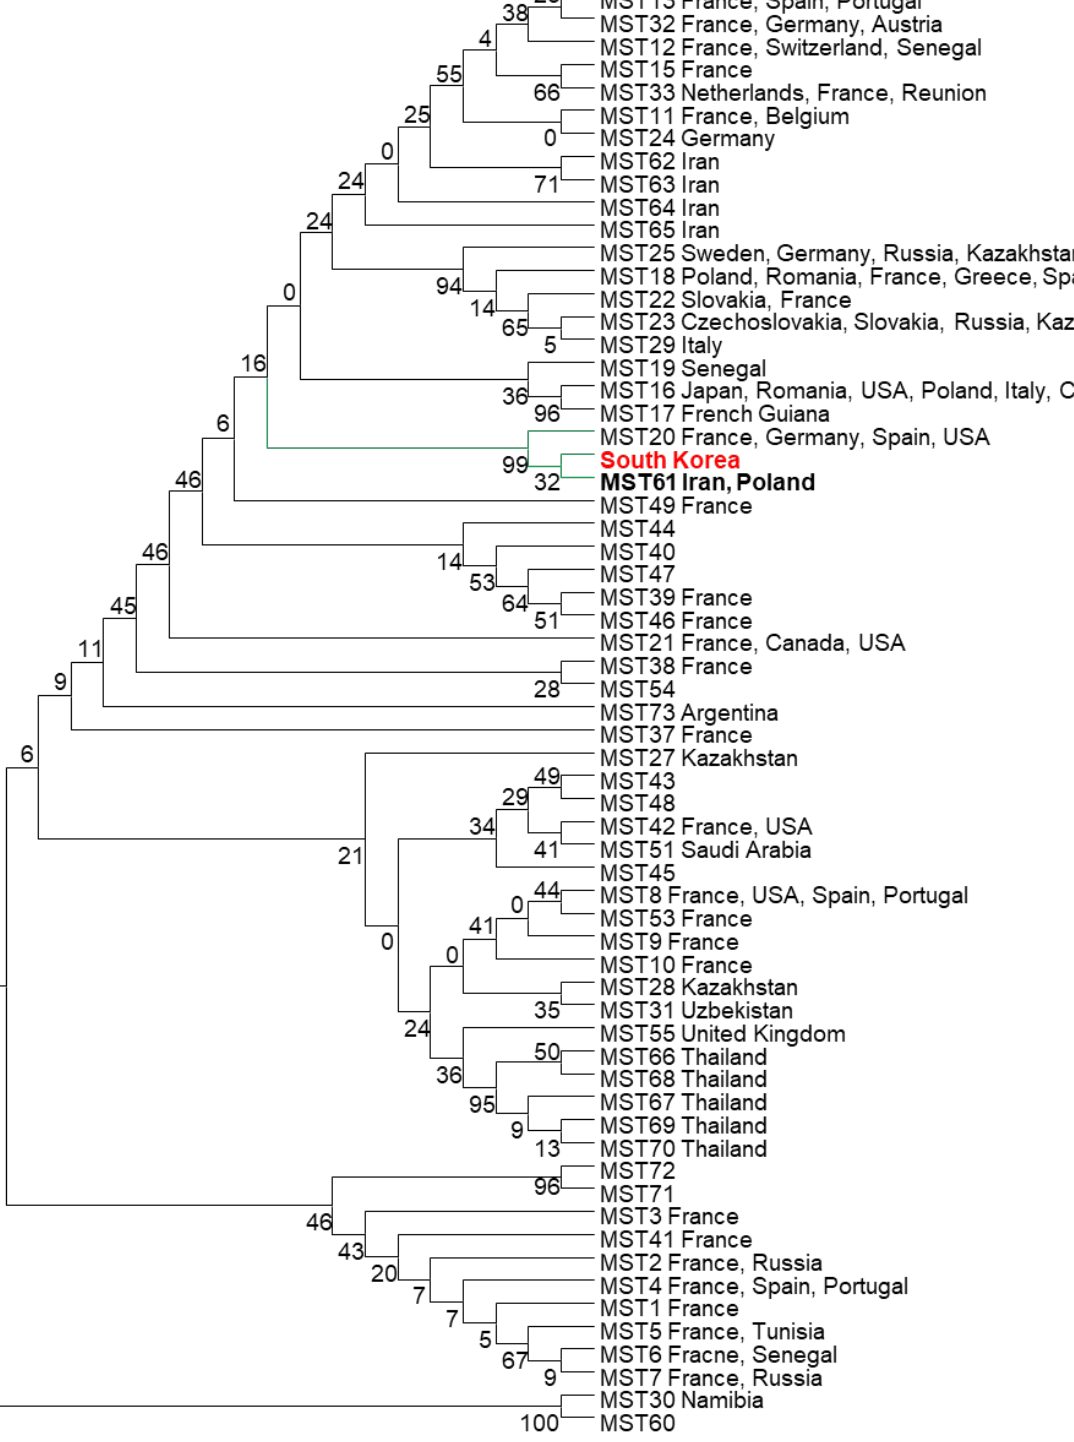
Figure 5. Phylogenetic tree showing relationships among the different groups of MST. Maximum- likelihood phylogenetic trees were created from sequences of C. burnetii detected from vaginal swab samples of cattle in South Korea and other MST groups using the Kimura 2-parameter model, γ distribution, and bootstrapping 500 times with MEGA7 software.